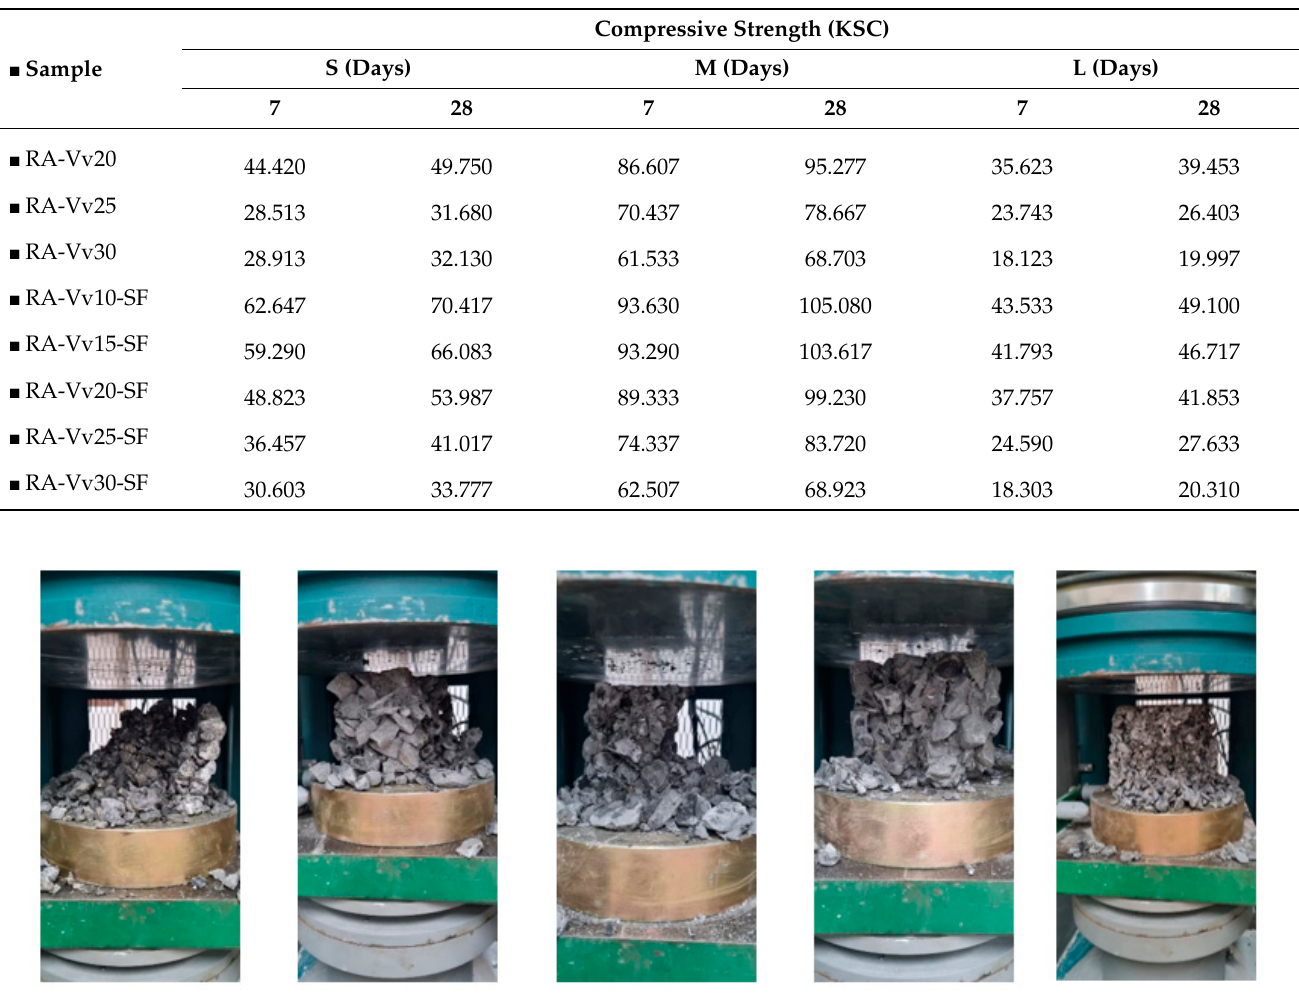
Figure 5. Ultimate failure modes of cube specimens.